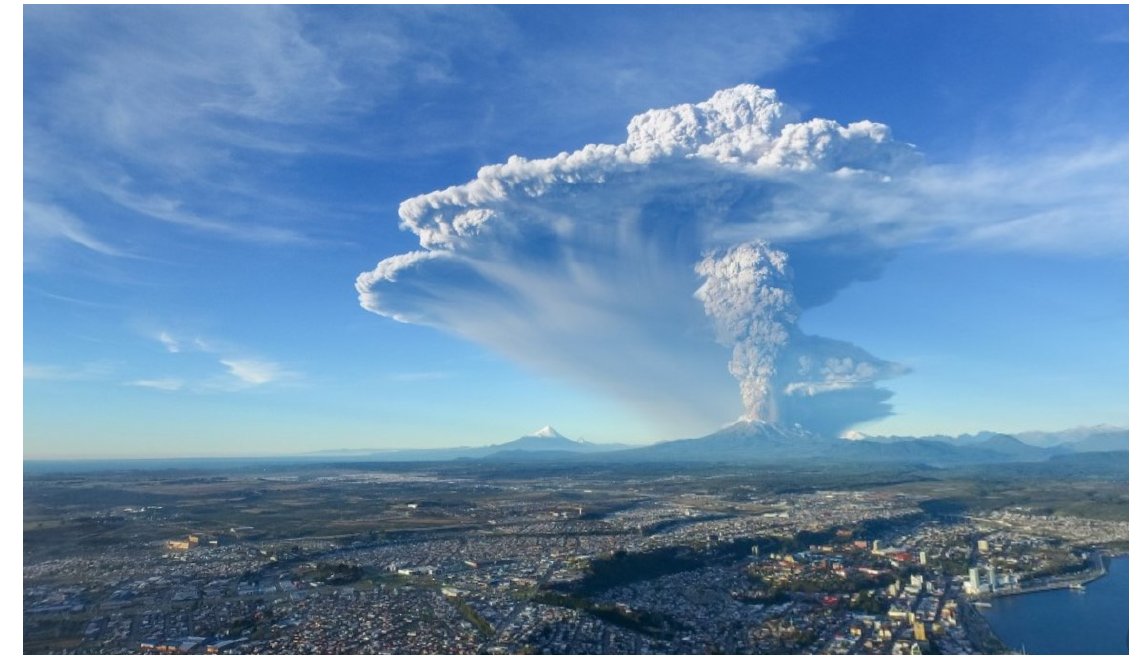
Figure 2. Eruption of the Calbuco Volcano during 22 April 2015. In the foreground is the city of Puerto Montt by the Pacific coast (founded in 1853), and in the background to the east are the Andes. Note the eruptive plume of the volcano in a west–east direction as a result of persistent westerly winds. The F. cupressoides sampling forest is located just behind the volcano under the eruptive plume. Photo credit: MAV Drone, César Santana https://www.facebook.com/mavdrone/ (accessed on 12 November 2019). Table 1. Historical eruption records of the Calbuco volcano [50–52].